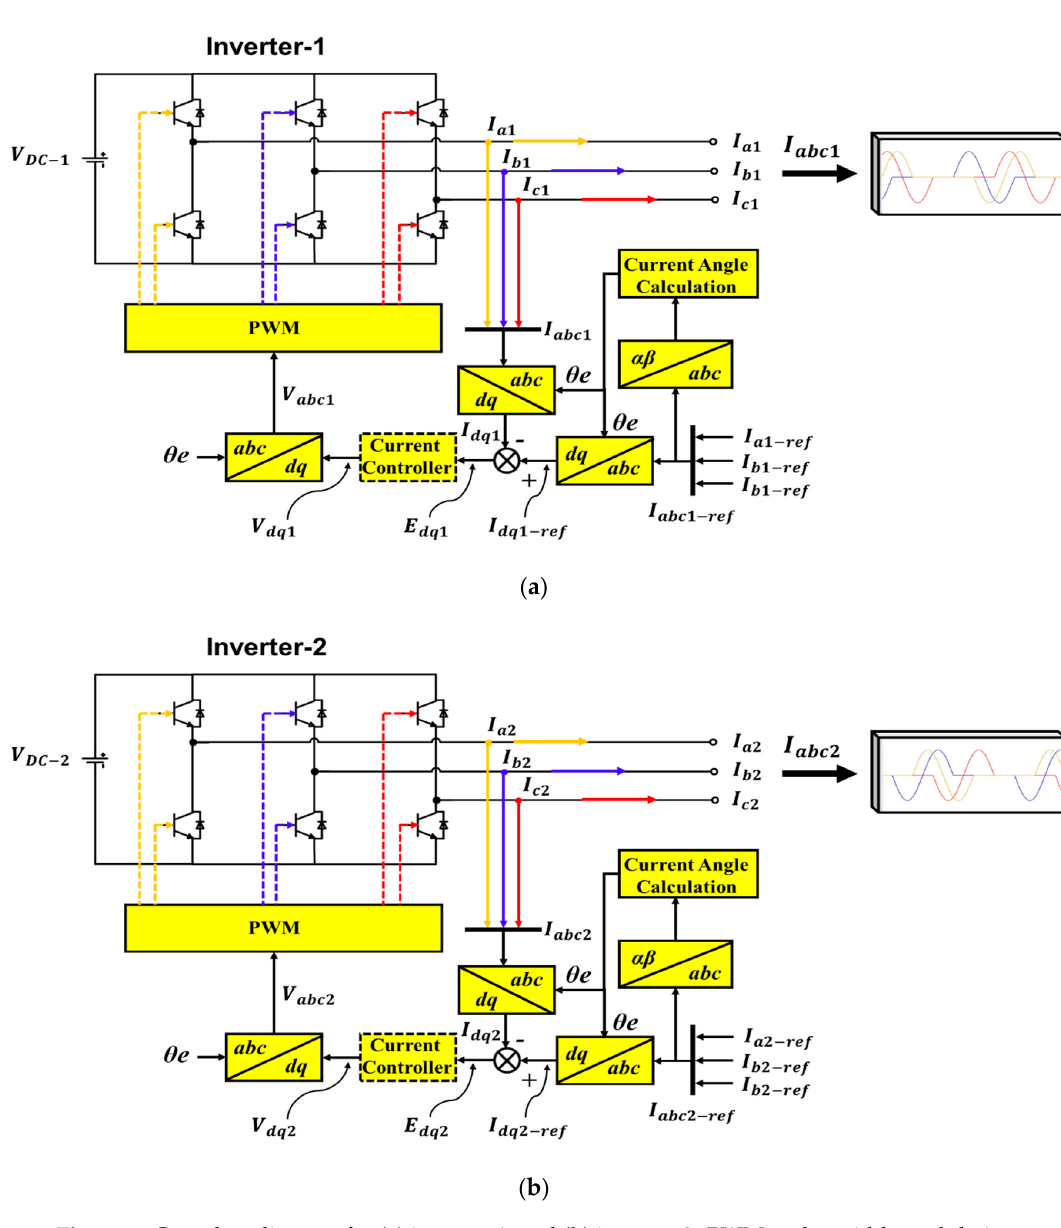
Figure 3. Complete diagram for ( a ) inverter-1, and ( b ) inverter-2. PWM: pulse width modulation.